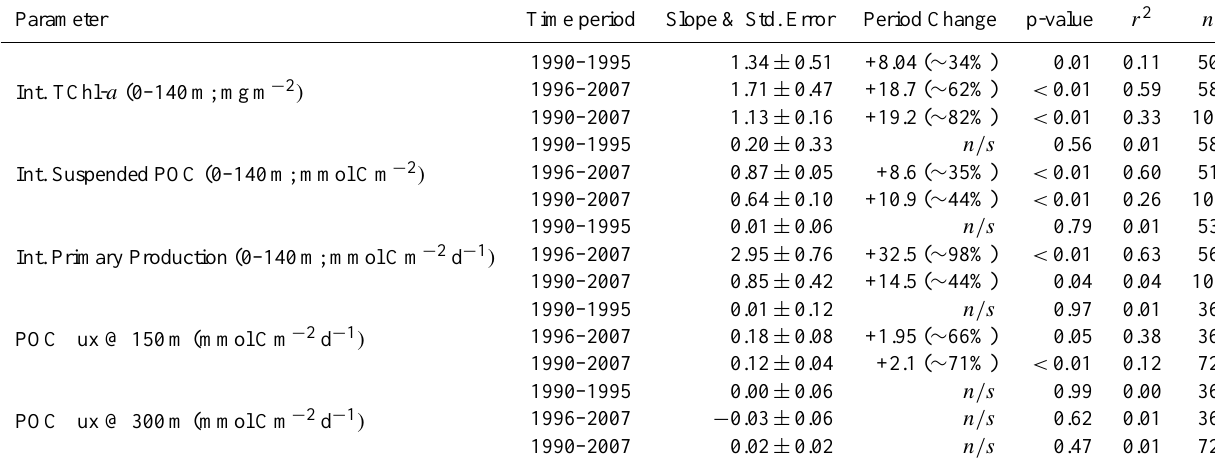
Table 1. Rates of change in biogeochemical parameters in the Sargasso Sea. Statistics provided for the entire period, as well as divided up into the two periods of interest as defined by the phase of the winter NAO index. n/s =no significant change. Data in the “Period Change” column are given as the absolute change, in appropriate units, from the beginning of the time period as well as the percent change in